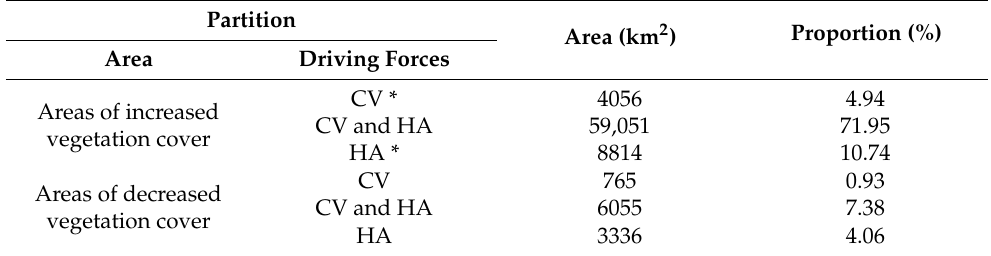
Table 5. Area and proportion of vegetation-cover changes influenced by different drivers.